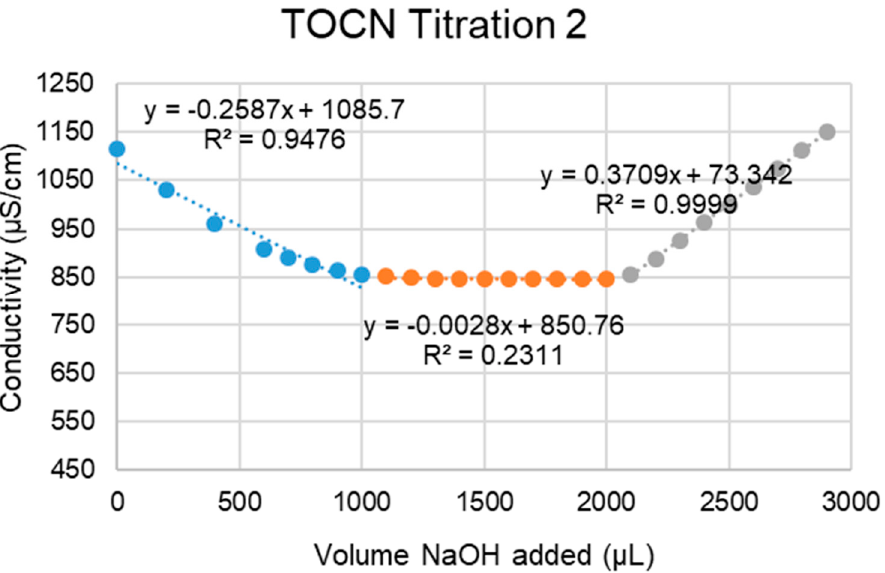
Figure A2. Conductivity vs. volume NaOH added for the second TOCN titration.